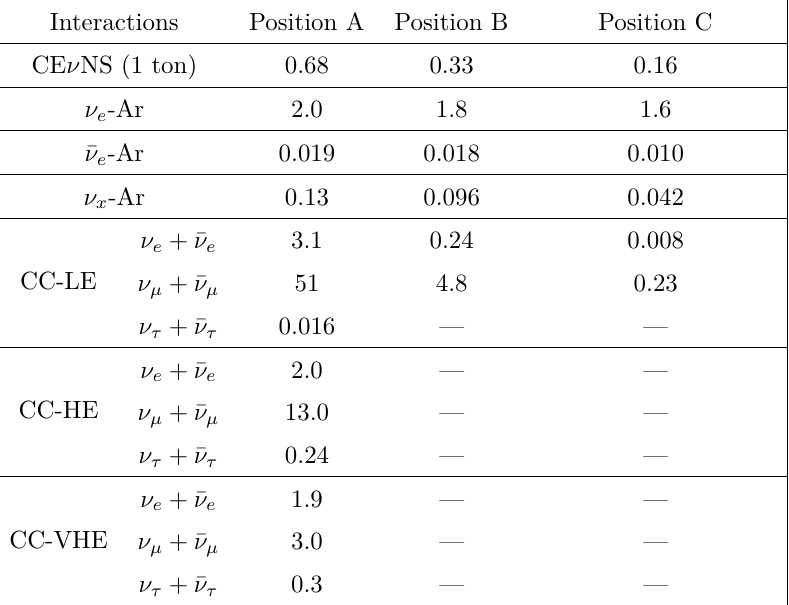
Table 1. Number of events per dump for the different interactions in a 100 ton liquid argon detector, except for CE ν NS which we assume 1 ton. CC-LE corresponds to CC interactions with E ν ≤ 10 GeV, CC-HE in the range 10 GeV ≤ E ν < 100 GeV, and CC-VHE for E ν ≥ 100